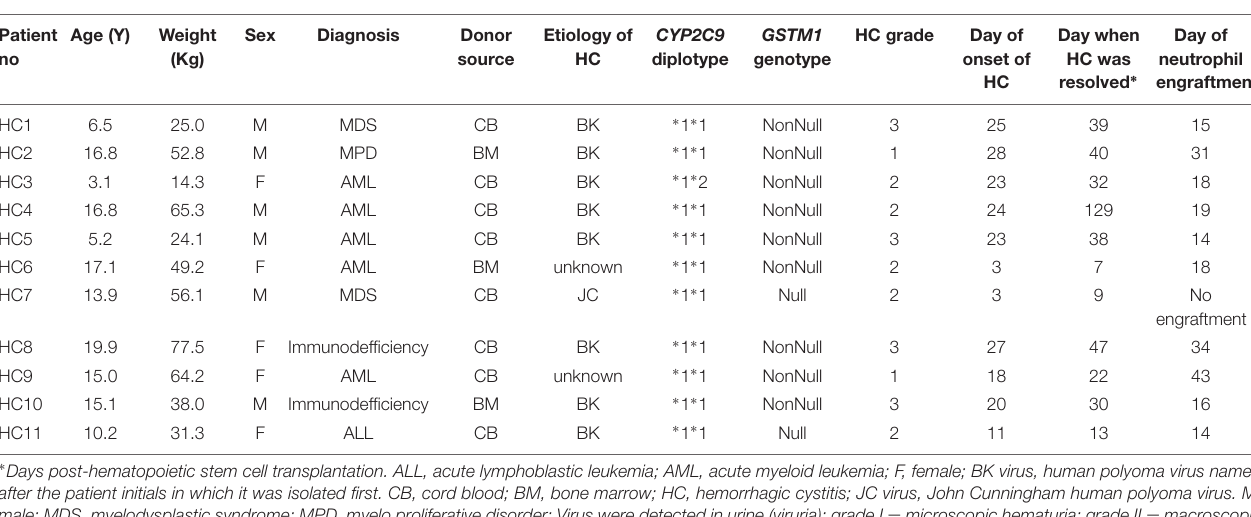
arrest with no live cells seen attached after 48 h. Ac showed higher binding of annexin V and increased apoptosis in HUC cells at 33 µ M = 1.8 µ g/mL and 50 µ M = 2.8 µ g/mL (Supplementary Figure S5A) and Su did not show any increase in apoptosis at concentrations lower than 1 mM (Supplementary Figure